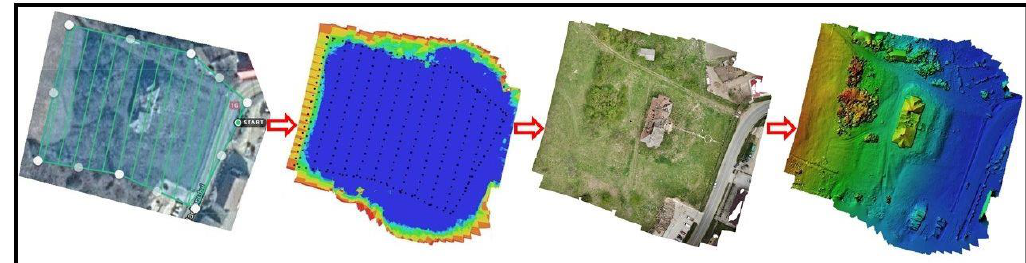
Figure 6. Photogrammetry processing stages.